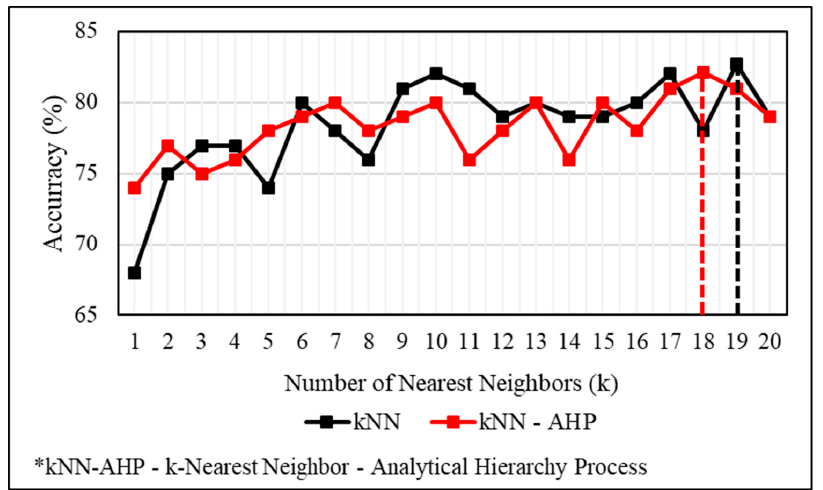
Figure 8. Relation among the number of Nearest Neighbors (k) and accuracy of models. Table 2. Model performance based on the training and validating